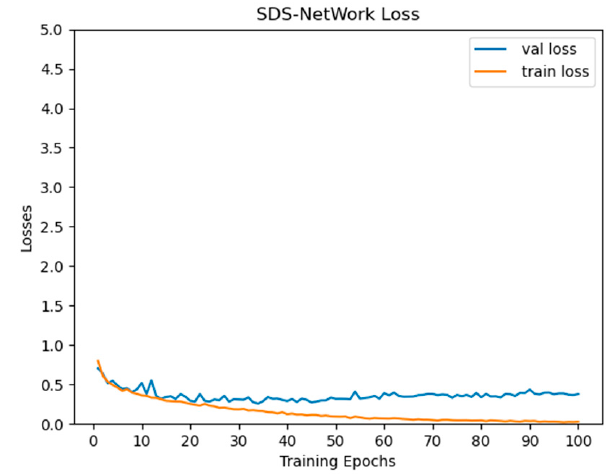
Figure 6. Loss curve diagram of SDS-Network algorithm.